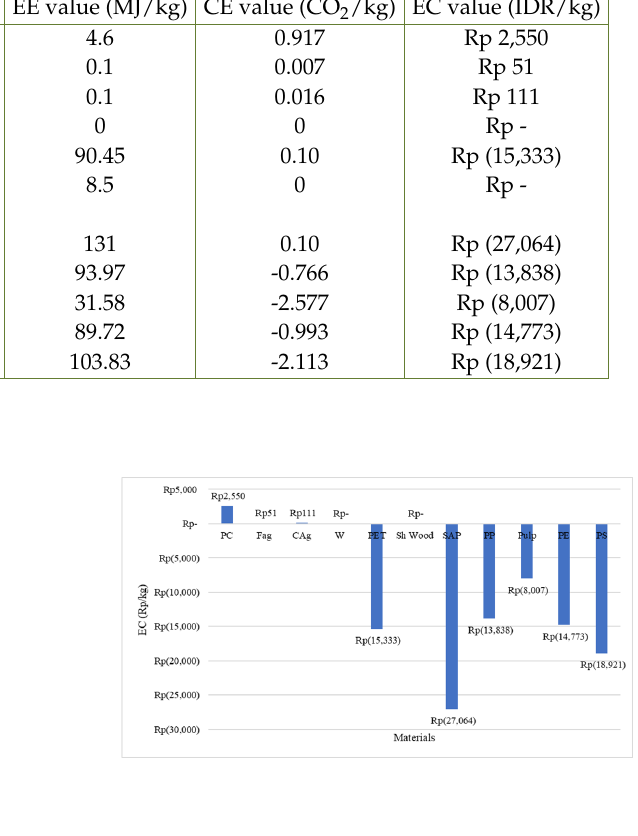
Fig. 3. EE Value of Concrete Materials (MJ/kg).